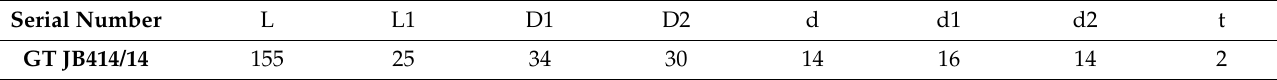
Table 2. Half-grouted sleeve parameters.